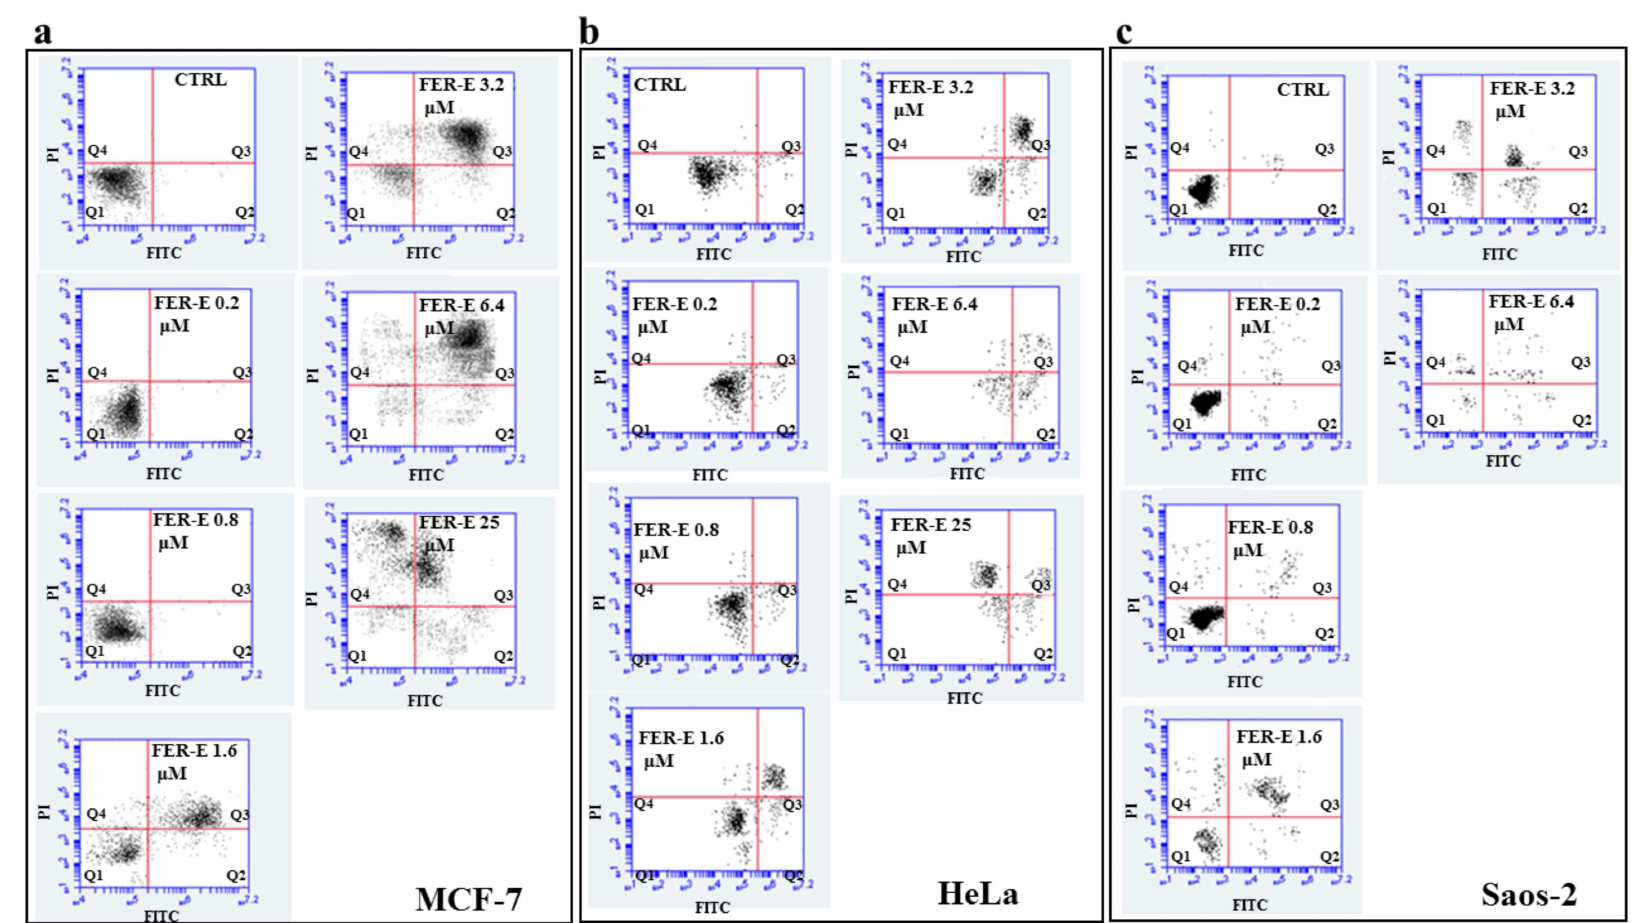
Figure 6. Mortality assessed by Annexin V Staining assay. Figure 6 shows the effect of treatment with different concentrations of FER-E on cell lines. In particular, in panels ( a – c ) the results for lines MCF-7, HeLa and Saos-2 are represented, respectively. Cytometric analysis was conducted on 20,000 events and each treatment is represented by a dot plot divided into 4 quadrants (Q1, Q2, Q3, and Q4). Q1 refers to Annexin V-negative/PI-negative cells (viable cells). Q2 refers to Annexin V-positive/PI-negative cells (apoptotic cells). Q3 refers to Annexin V-positive/PI-positive cells (late apoptosis). Q4 refers to Annexin V-negative/PI-positive cells (advanced necrosis). A representative experiment of three independent experiments was